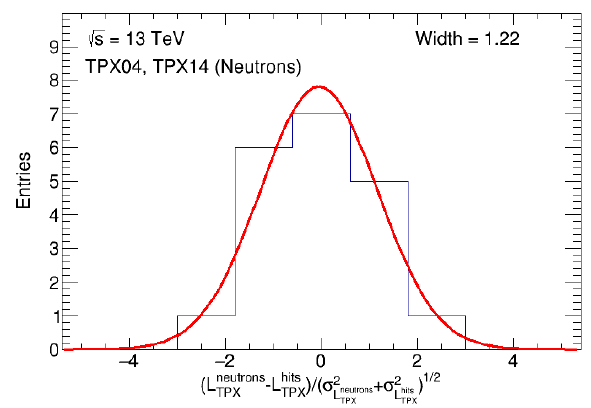
) 1/2 , where σ − L hits ) / ( σ 2 + σ 2 L neutrons TPX is the statistical TPX TPX L neutrons TPX L hits TPX the fill-by-fill uncertainty on the TPX hit- L hits TPX